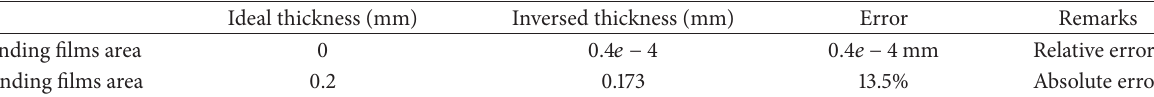
Table 7: Inversed results from far field pattern by HFSS.